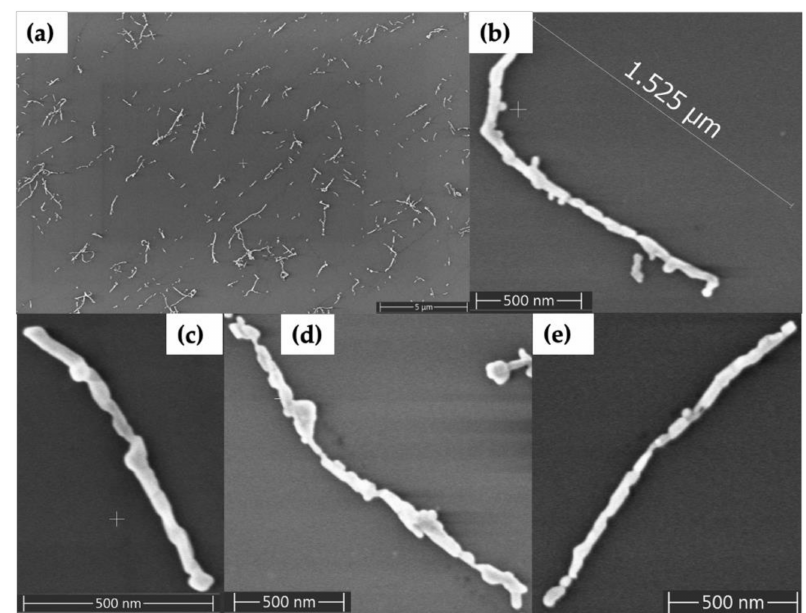
Figure 4. SEM images of Au nanorod-seeded and Au-plated DNA nanotubes. ( a ) Large area view. ( b – e ) Zoom views of individual plated DNA nanotubes.